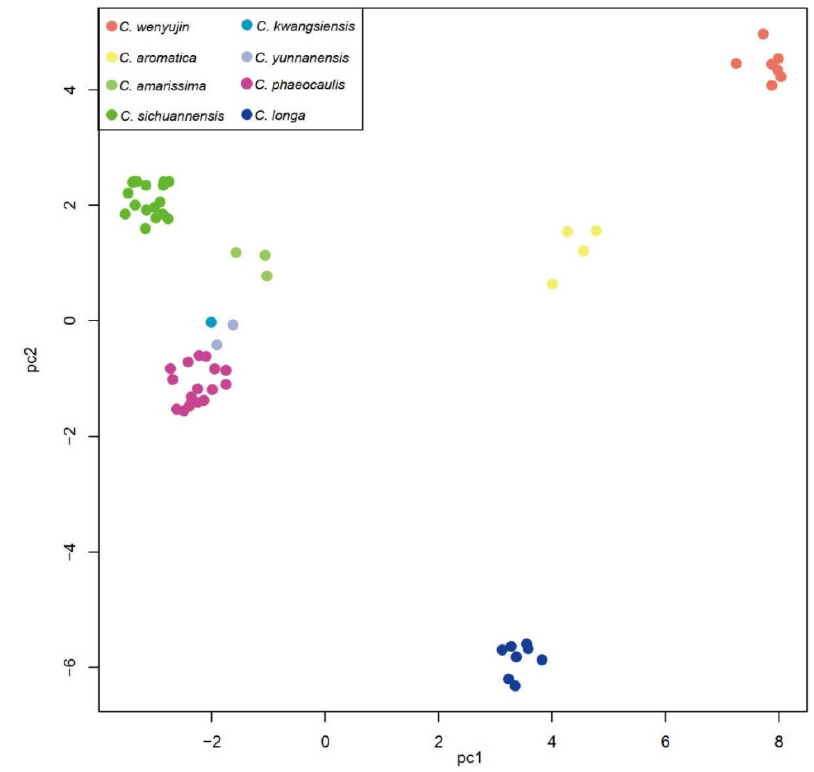
Figure 2. The principle components analysis of Chinese Curcuma . Principal component analysis (PCA) of the 60 individuals and different species with different colors.